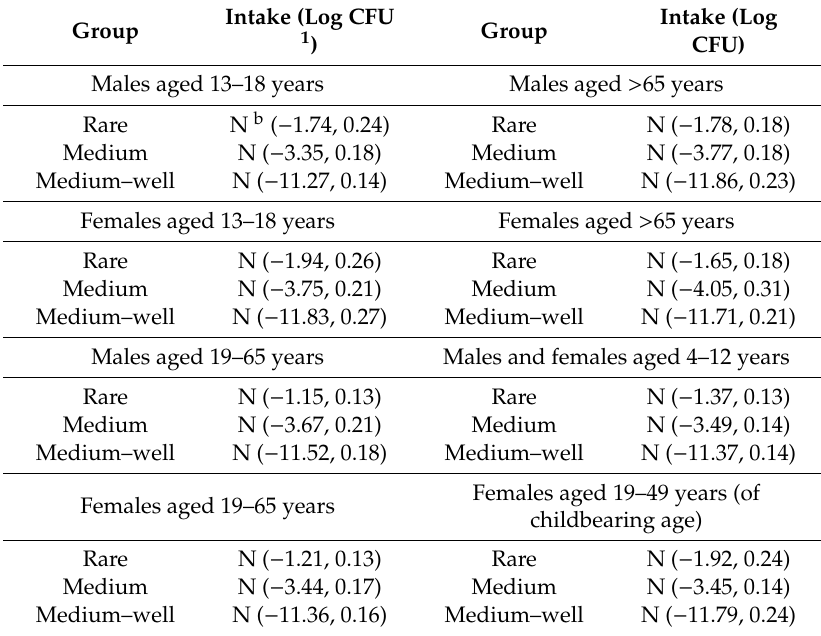
Table 2. Probability distribution of E. coli O157:H7 intake (Log CFU) from consuming beef imported 234 from the United States of America in the Taiwanese